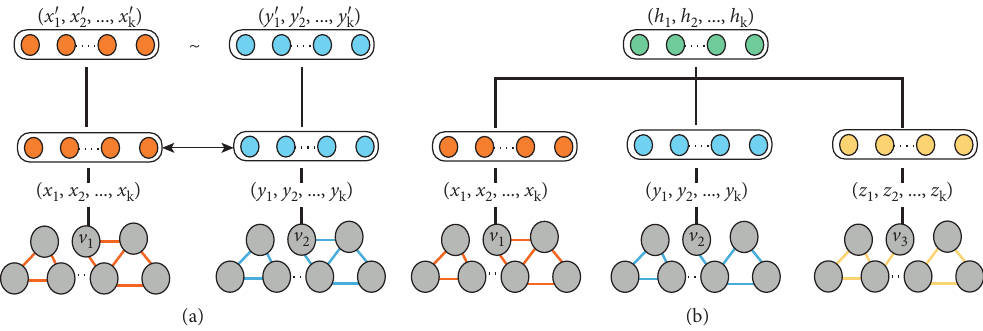
Figure 2: Structure of coordinated and joint representation fusion. Coordinated representation fusion achieves information interaction through the middle layers. Joint representation fusion directly fuses multiple information of nodes.